Question: State the chart type depicted above.
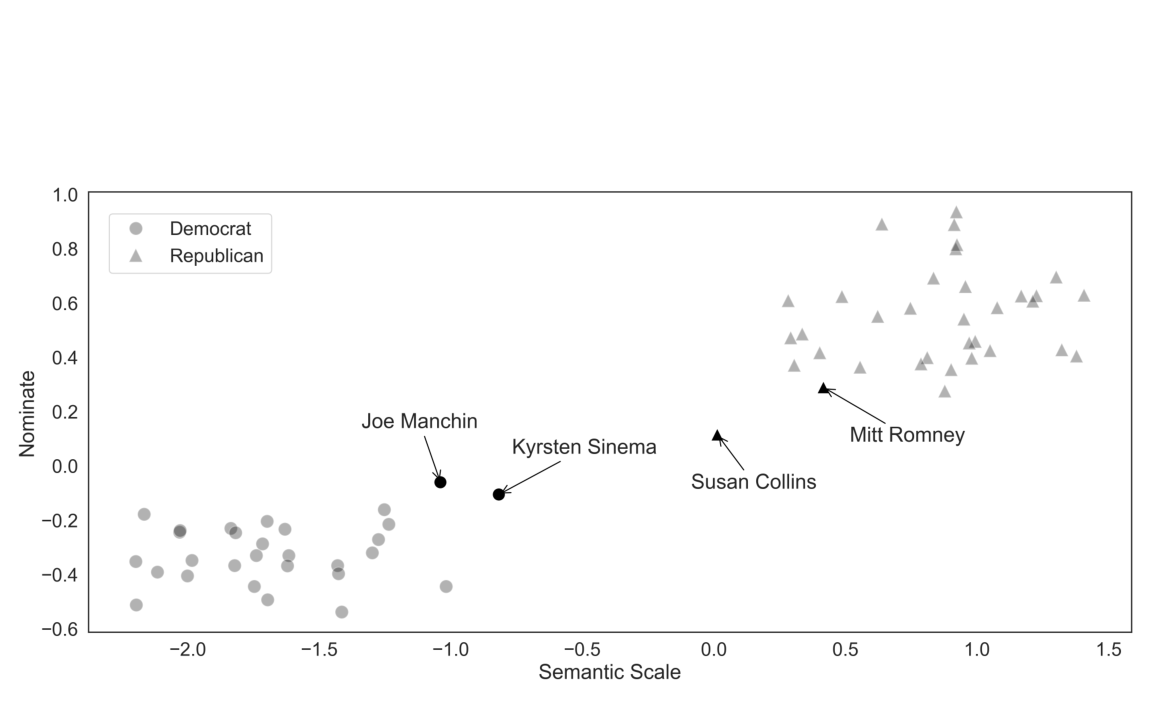
Answer: line